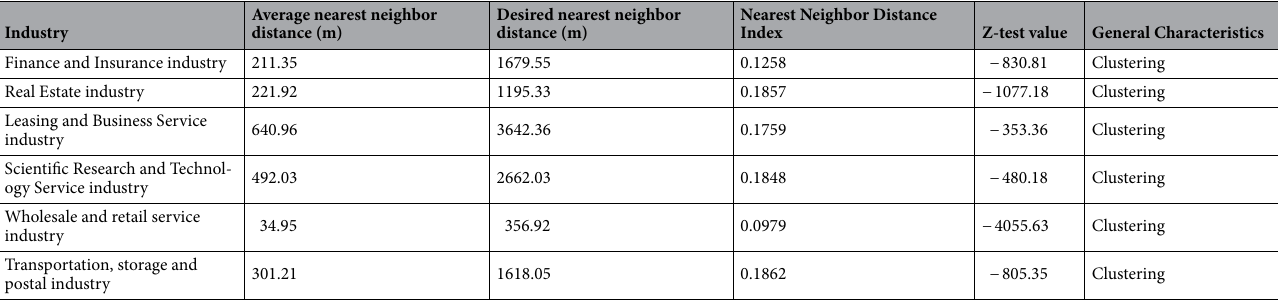
Table 2. Nearest Distance Index for producer